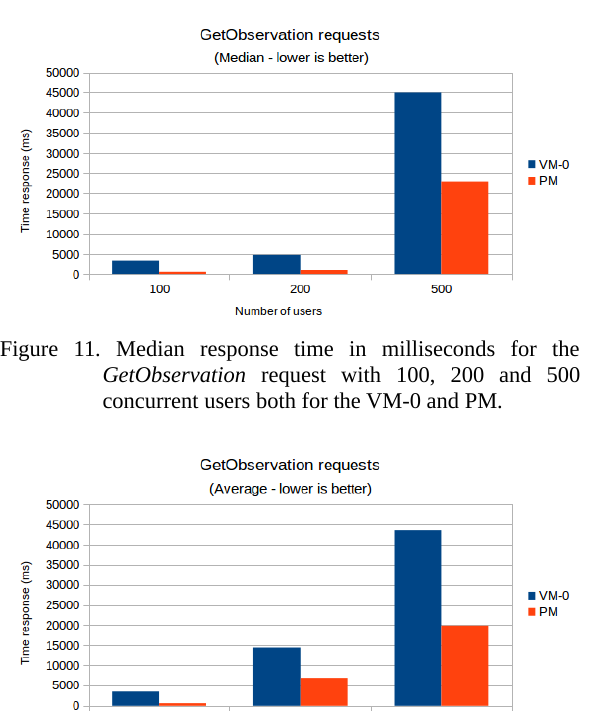
Figure 8. Average response time in milliseconds for the GetCapabilities request with 100, 200 and 500 concurrent users both for the VM-0 and PM.